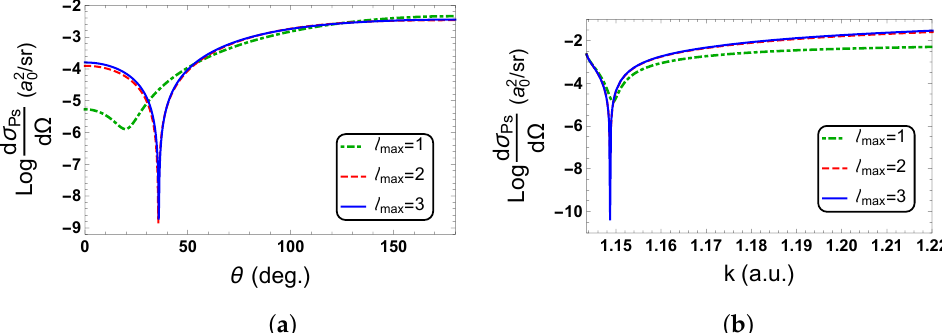
[ DCS ] , which we compute using the Figure 3. The common logarithm of Ps-formation DCS, log 10 complex Kohn K-matrices. The figures show the deep minimum in the logarithm of the cross section and the convergence of the cross section with respect to (cid:96) max , the maximum value of (cid:96) , which we use in Equation (1). ( a ) The logarithm of the Ps-formation DCS for k = k 0 = 1.1487 as a function of θ . ( b ) The logarithm of the Ps-formation DCS for θ = θ 0 = 35.9 ◦ as a function of k .